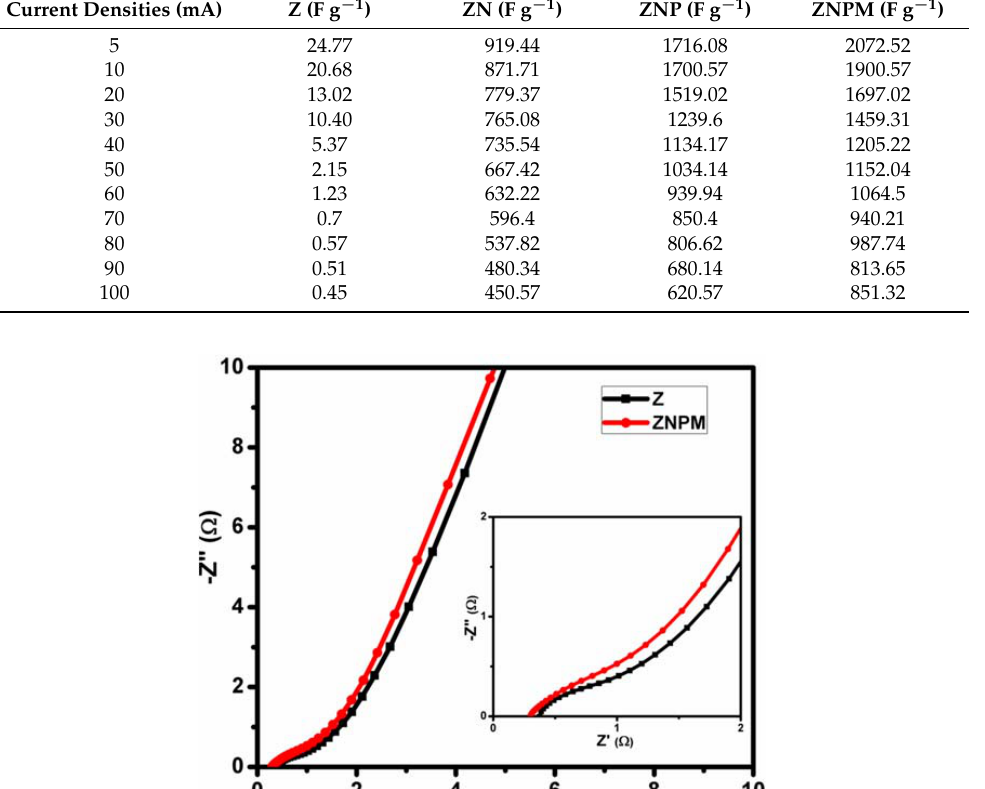
Table 1 Specific capacitance values of Z, ZN, ZNP, and ZNPM at different current densities.